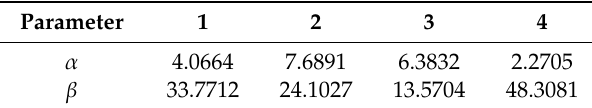
Figure 2. Temple and simulated synthetic aperture radar (SAR) images: ( a ) Temple image, ( b ) simulated SAR image. Table 1. Gamma parameters of a simulated SAR image.